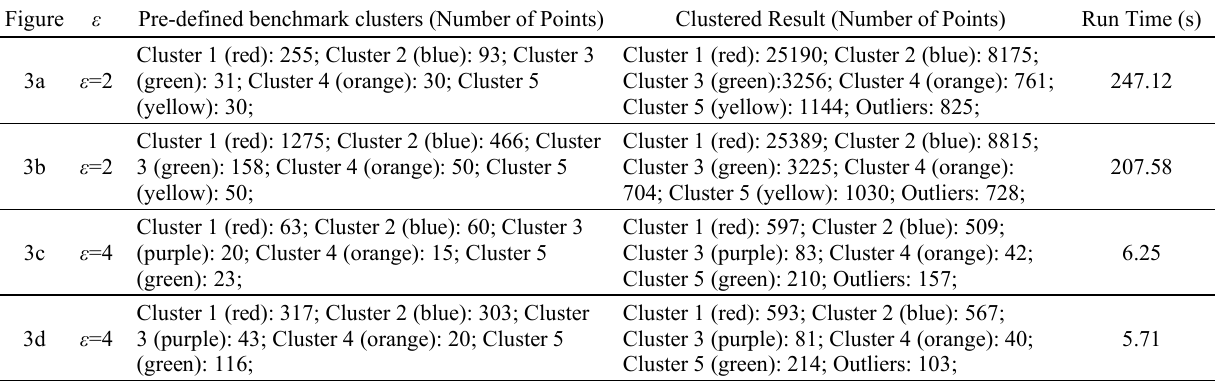
Table 2. Clustering parameters and clustered